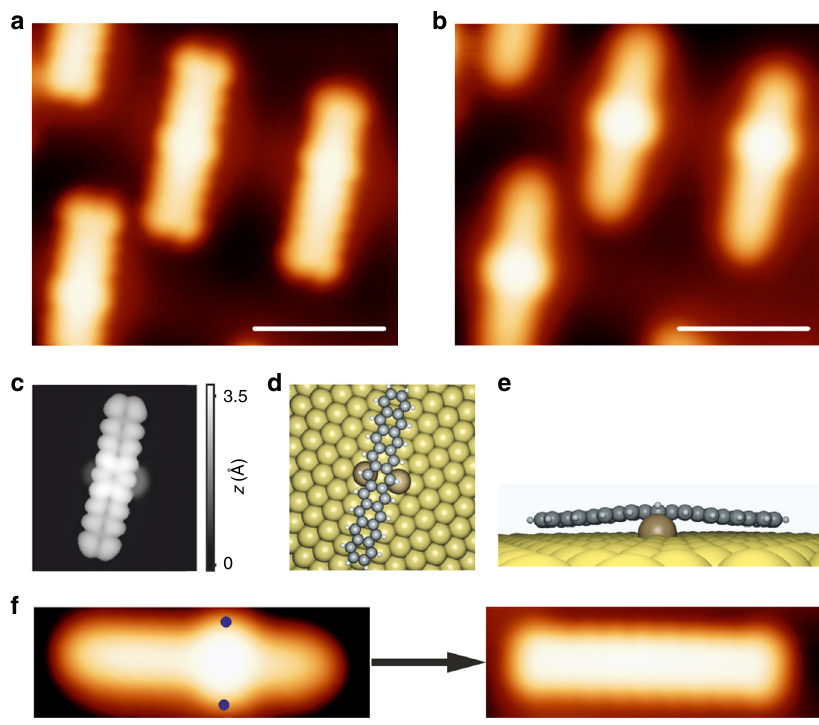
Fig. 3 Au-nonacene interactions. a , b High-resolution STM images showing the Au-nonacene interaction as two protrusions at certain V bias . These interactions are mostly observed around the central benzene ring, though they can also be detected around neighboring benzene rings. a V b = − 1.2 V, I = 15 pA. Scale bar: 2 nm. b V b = 2.3 V, I = 4 pA. Scale bar: 2 nm. c DFT simulated STM image of an individual nonacene molecule bound to two Au adatoms. V = − 1.5 V. d , e Top and side views of the corresponding DFT equilibrium geometry. f High-resolution STM images demonstrating the removal of the Au b adatoms. Left STM image V b = 2.0 V, I = 65 pA. Right STM image V b = − 1.0 V, I = 50